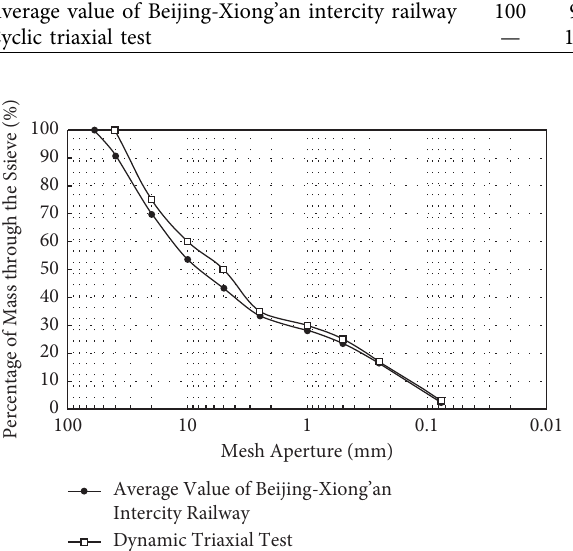
Figure 1: Gradation curve of cyclic triaxial test Sample.